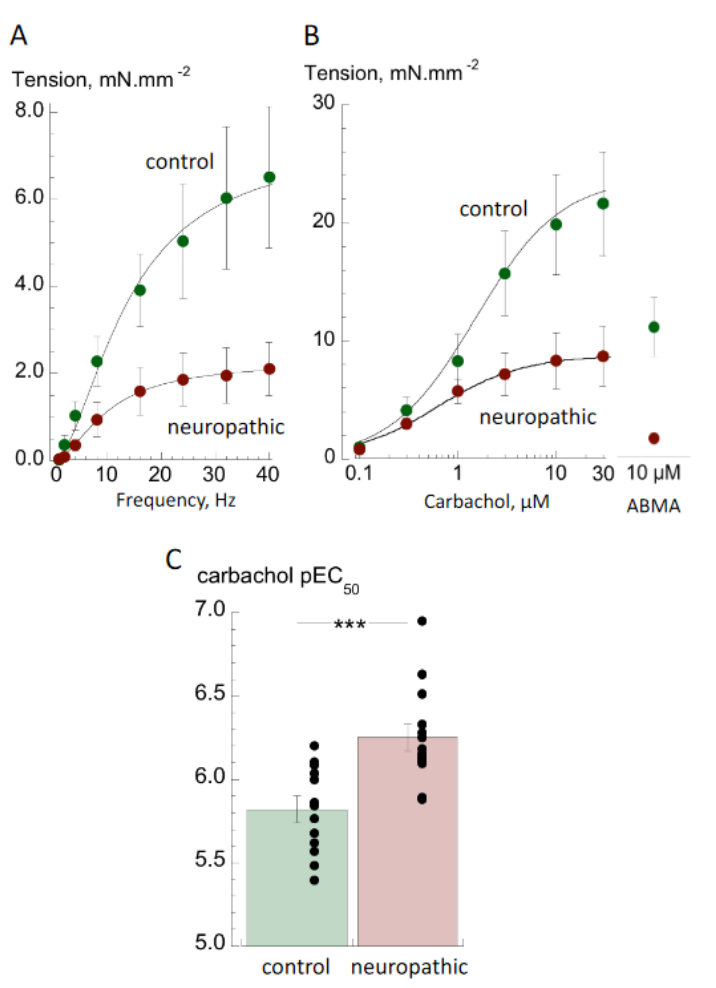
Figure 1. Contractile properties of detrusor preparations from neuropathic and control bladders. ( A ): Nerve-mediated contractions as a function of stimulation frequency (mean ± SEM, n = 10,14; neuropathic vs. control). ( B ): Carbachol concentration–response curves ( n = 14,13) and the response to 10 µM ABMA ( n = 14,11). ( C ): Dot plots and bar chart (mean ± SEM) of carbachol p EC 50 values ( n = 14,13), *** p < 0.001 neuropathic vs. control.